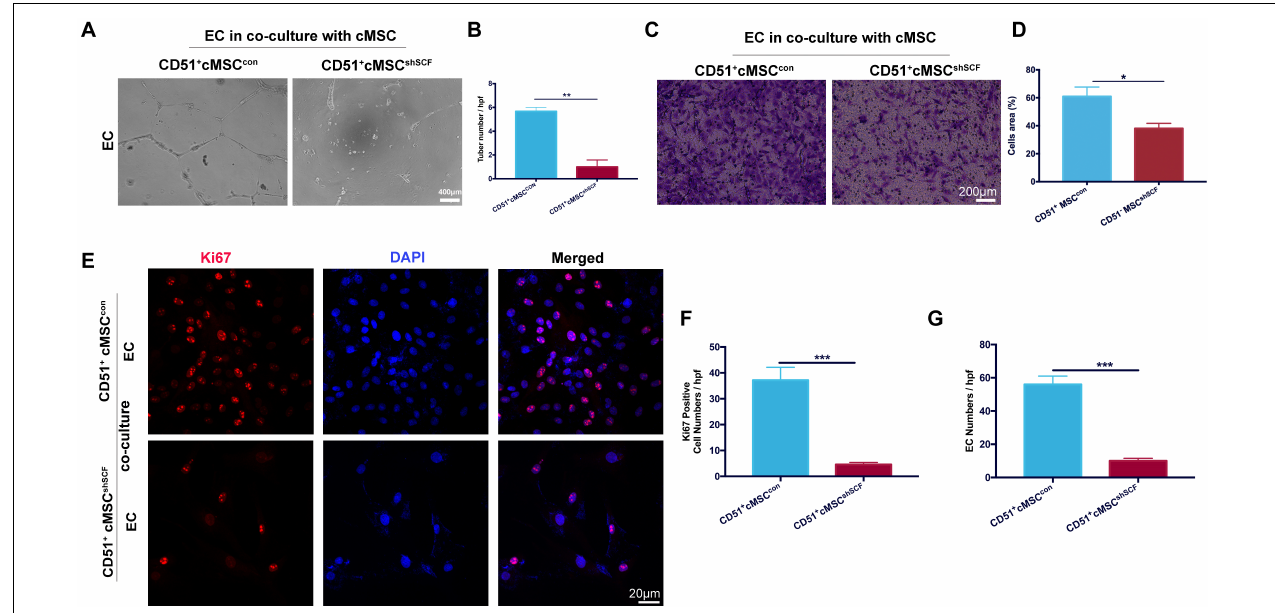
FIGURE 7 | SCF downregulation in CD51 + cMSCs decreased function of endothelial cells in vitro . (A , B) Tube formation of endothelial cells on Matrigel-coated dishes when co-cultured with CD51 + cMSC shSCF , or CD51 + cMSC con under hypoxia conditions; number of tubes per high-power field (hpf) was analyzed, n = 3. (C , D) Transwell array: migration of endothelial cells when cocultured with CD51 + cMSC shSCF , or CD51 + cMSC con under hypoxia conditions, endothelial cells were stained by crystal violet, and area percentage of cells in each hpf area was analyzed, n = 5. (E – G) Representative images of immunofluorescence staining with Ki67 antibody in endothelial cells after being cocultured with CD51 + cMSC shSCF , or CD51 + cMSC con under hypoxia conditions: Ki67 (red), DAPI (blue); numbers of Ki67-positive cells and total endothelial cells per field were analyzed, n = 5. EC, endothelial cells. Data in all panels were presented as means ± SEM, * P < 0.05, ** P < 0.01, and *** P <